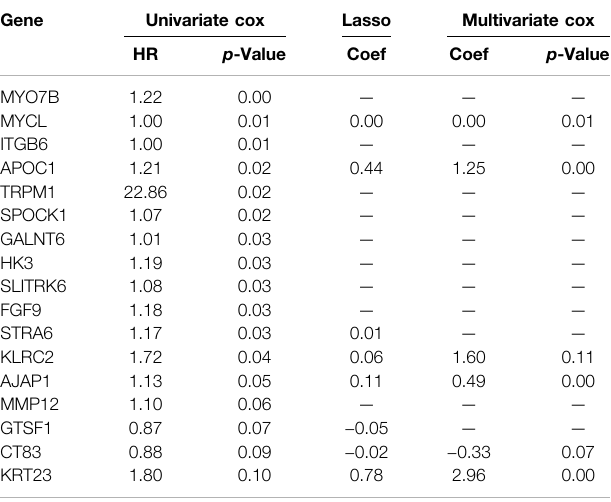
TABLE 6 | Univariate Cox regression, lasso regression, and multivariate Cox regression were used to identify SPOCD1 related prognostic genes. Gene Univariate cox Lasso Multivariate cox